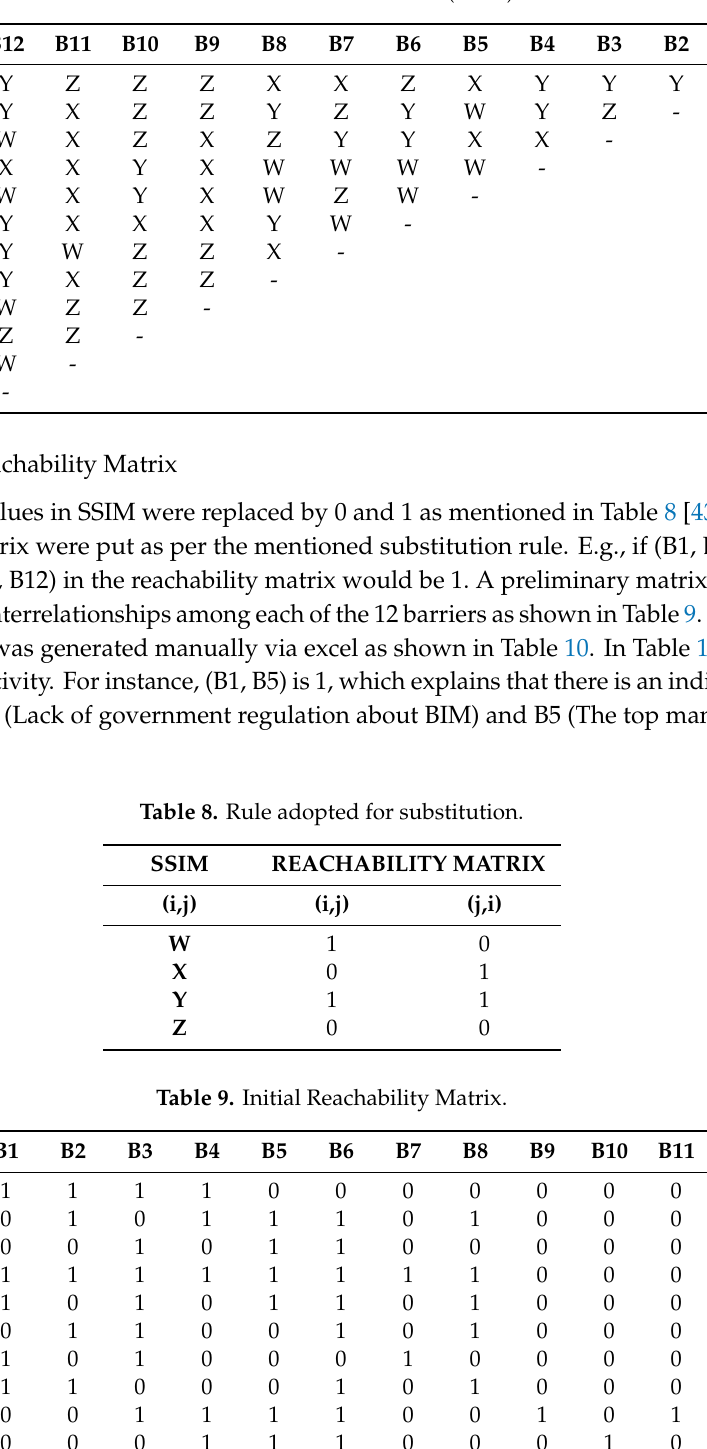
Table 7. Structural Self-Interaction Matrix (SSIM) for barriers.